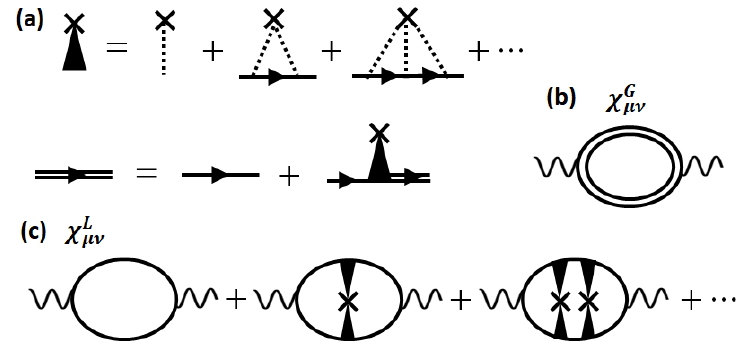
Figure 1: (a) Feynman diagrams for the self-energy Σ caused by impurity scattering, and the full Green’s function solved by Dyson’s equation G = G ( 0 ) + G ( 0 ) Σ G . (b) The susceptibility χ G calculated from the full Green’s function, and (c) χ L µν the ladder diagram